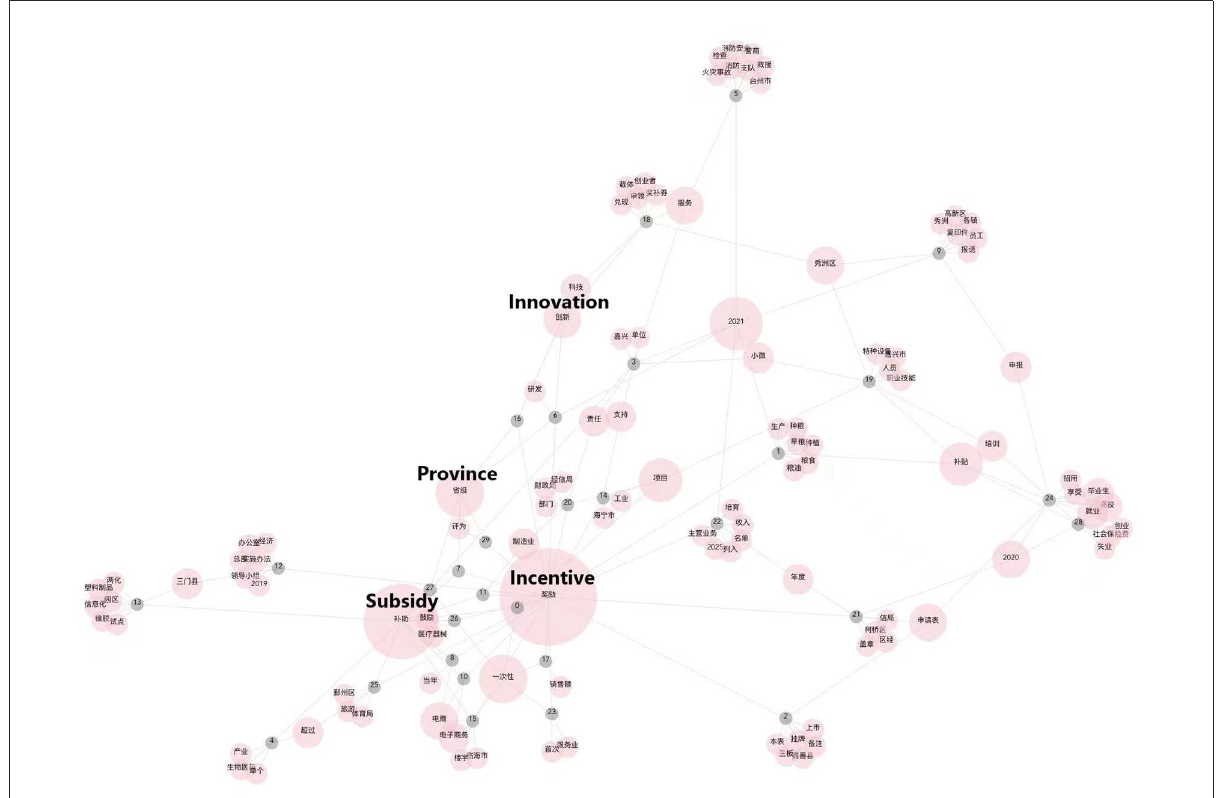
FIGURE4 Network visualization of co-occurrences of key words in policy